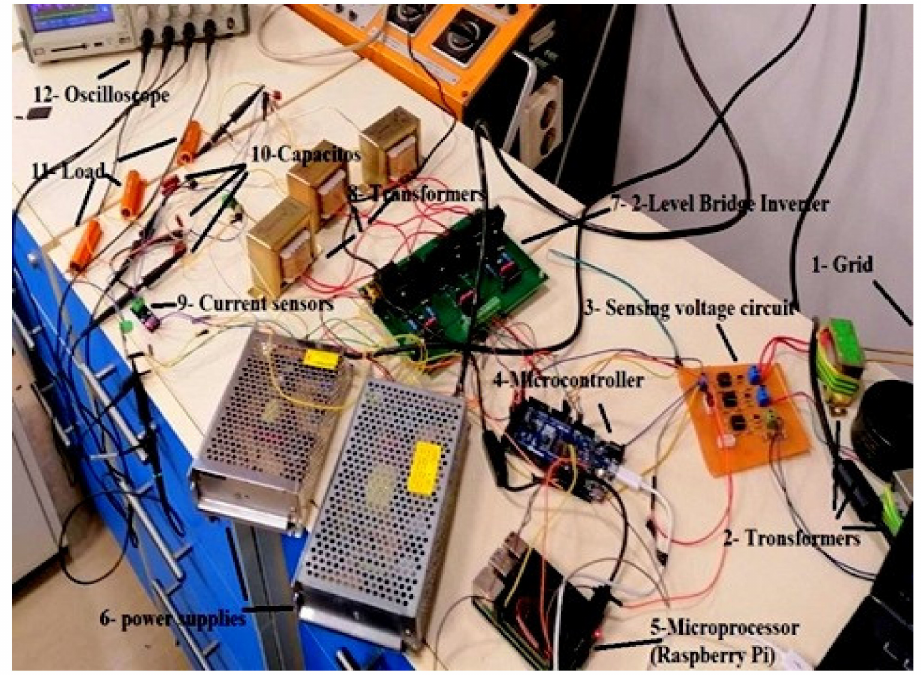
Figure 15. Hardware experiment